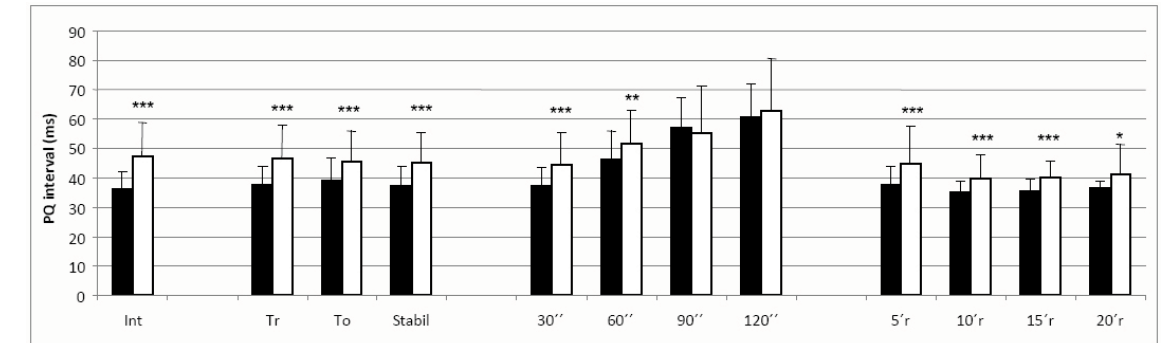
Figure 3. Mean ± SD values of the PQ interval duration in intact animals (Int), after tracheotomy (Tr), thoracotomy (To), 5 minutes after stabilization (Stabil), during each 30 seconds of 2-minute apnoeic episodes, and after 5, 10, 15, and 20 minutes of artificial reoxygenation. Empty and black columns refer to light and dark parts of the day, respectively. The level of significance of differences between the light and dark part of the rat daily regimen is indicated by the symbol (* p < 0.05, ** p < 0.01, *** p < 0.001).